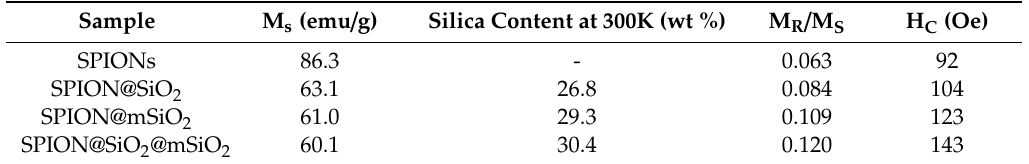
Table 1. Magnetic properties of the nanoparticles (M S —magnetization saturation, M R —remanence, H C —coercivity).